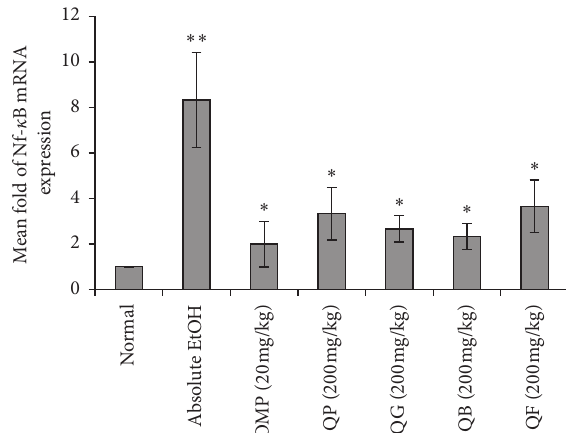
Figure 9: Effect of the four types of processed quinoa seeds on the expression of NF- κ B gene in the stomach tissues of experimental rats. Fold change of NF- κ B gene expression normalized to GAPDH as a reference housekeeping gene. ∗∗ p < 0 . 05 compared to normal. ∗ p < 0 . 05 compared to absolute